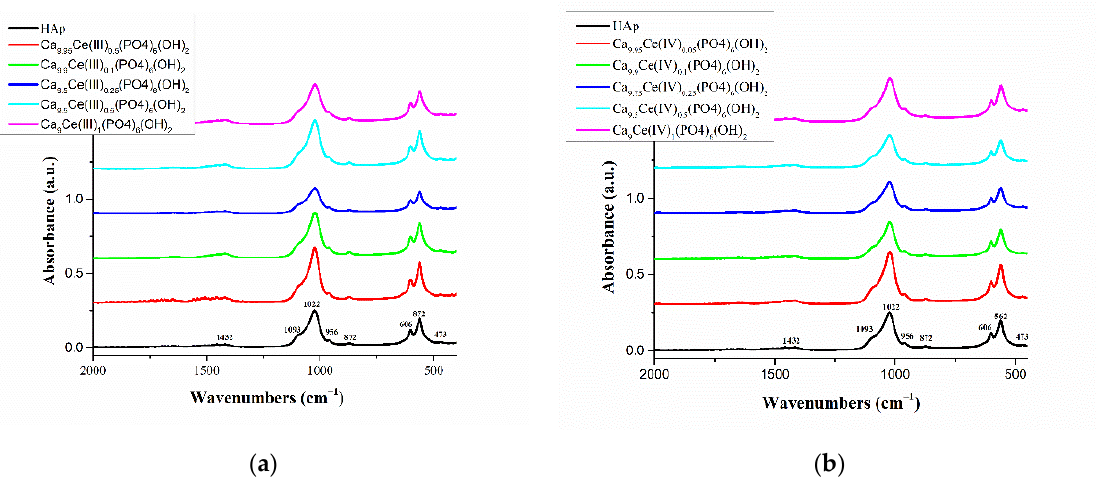
Figure 1. FTIR spectra of ( a ) hydroxyapatite (HAp) and Ca 10-x Ce(III) x (PO 4 ) 6 (OH) 2 ; ( b ) hydroxyapatite (HAp) and Ca 10-x Ce(IV) x (PO 4 ) 6 (OH) 2 .